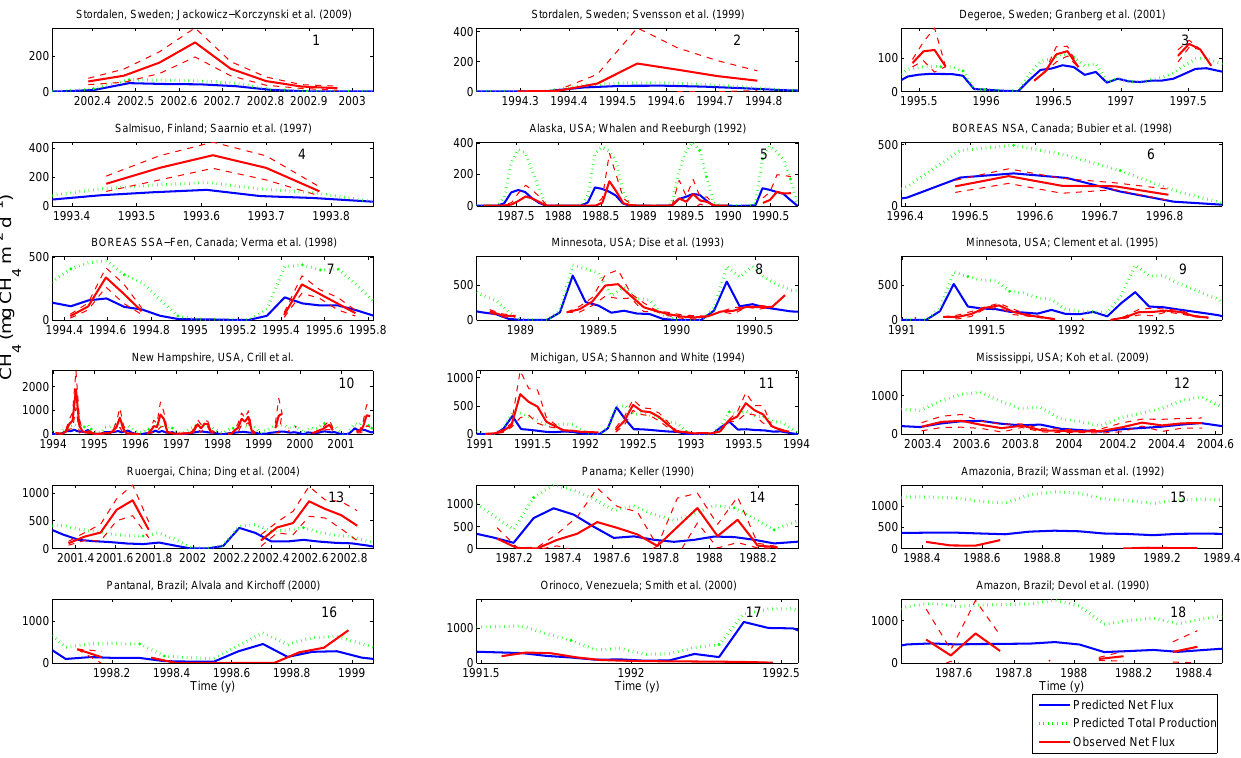
Fig. 4. Comparison between monthly-mean simulated net CH 4 flux, simulated total CH 4 production (i.e., net CH 4 emission + oxidation), and observed net CH 4 flux (1 standard deviation bounds are shown as dashed lines). Citations for the datasets are given in title of each subplot and Table 3.